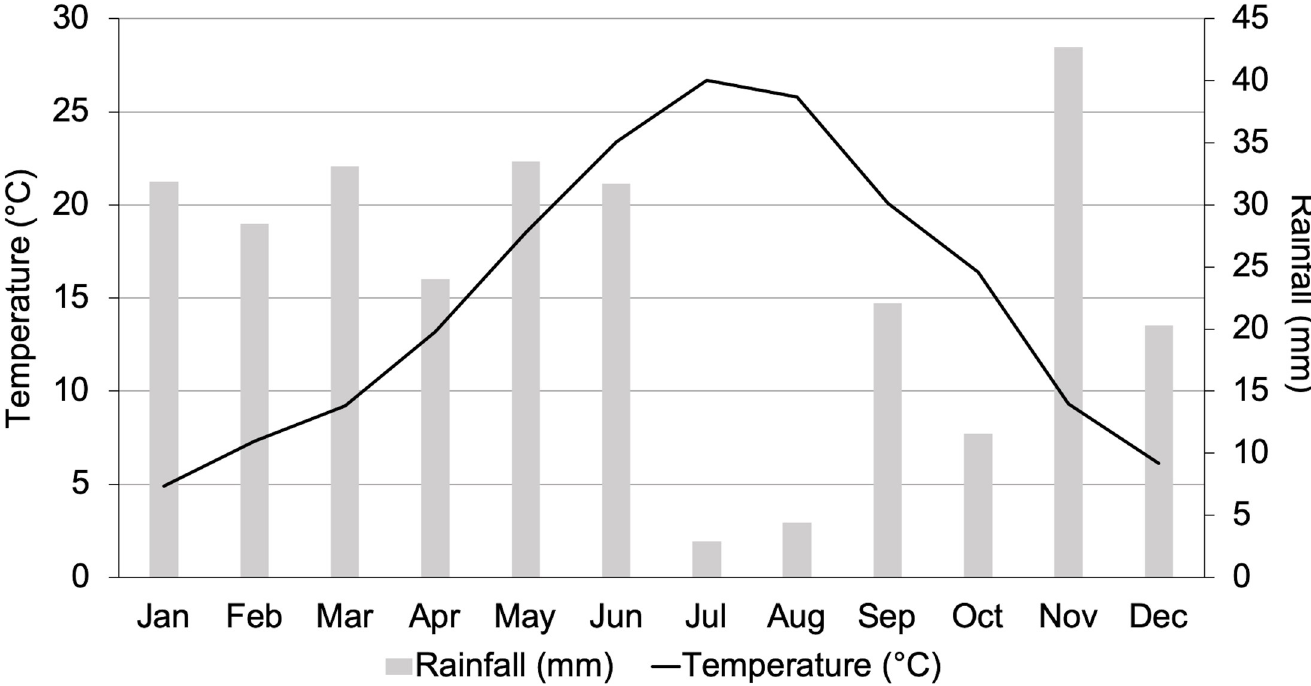
Fig 3. Monthly mean temperature and relative humidity in Setif province, North-Eastern Algeria, based on average data recorded during 2016 and 2017. https://doi.org/10.1371/journal.pntd.0008024.g003 males. Lilliefors test was used to test the normality of the data. The total number of specimens for each species collected monthly and the number of females and males according to species were compared using non-parametric tests (Kruskal-Wallis H-test, Mann-Whitney U-test) respectively. Spearman’s ( rs ) correlation coefficients were used to assess the relationship between the number of sand flies and meteorological variables (i.e., average monthly tempera- ture, relative humidity, rainfall and wind speed). Statistical analyses were performed using IBM SPSS statistics 23 rd version for Windows 10. Differences were considered statistically sig- nificant when P < 0.05.